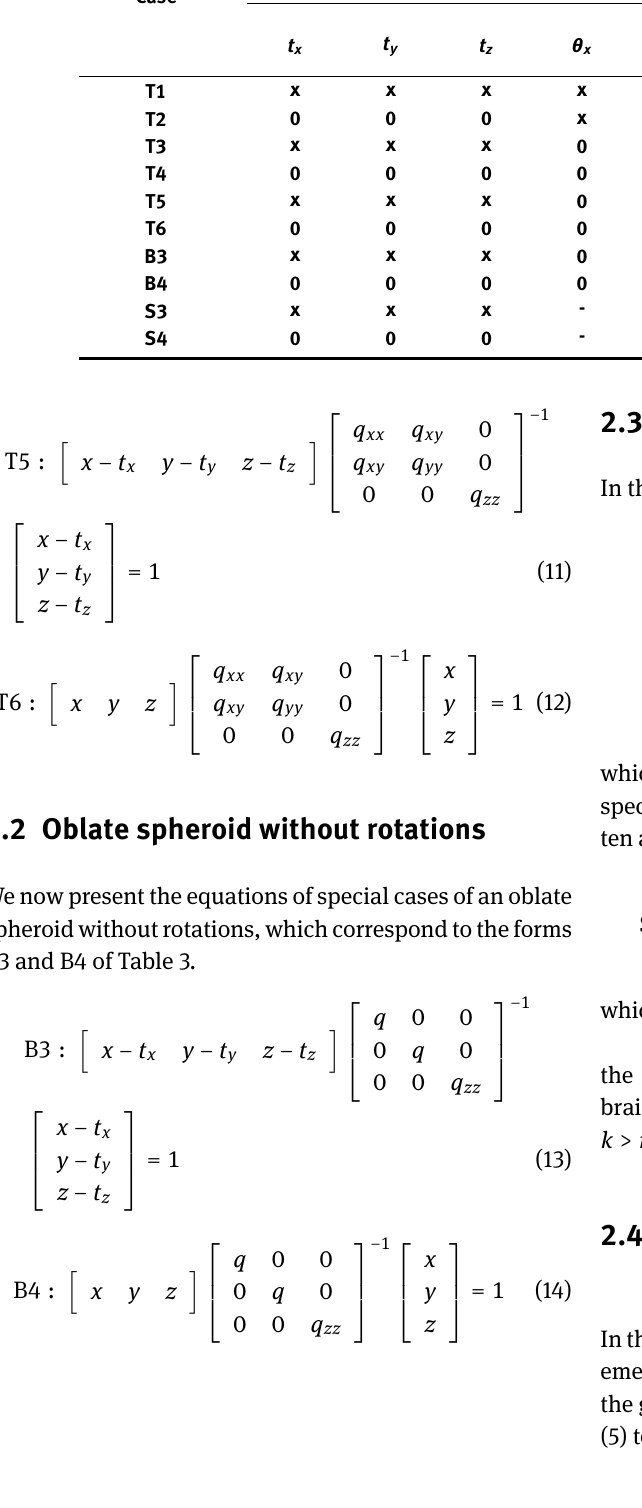
Table 2. Parameters for different cases of a triaxial ellipsoid and degenerate cases